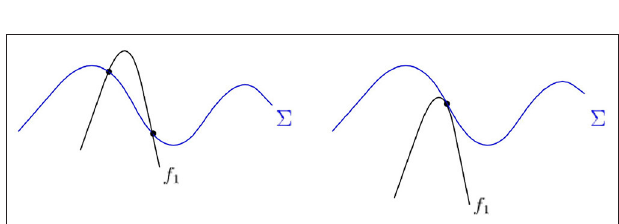
FIGURE 12 | Singular saddle-node type 1: g = f 1 = 0, f 1 x g y − f 1 y g x = 0, g x 6=